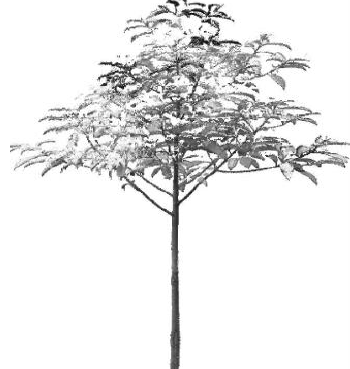
(b) Scanning coniferous trees by using the LiDAR and imaging spectrometer. Figure 2. The scenes of acquisition ground data.